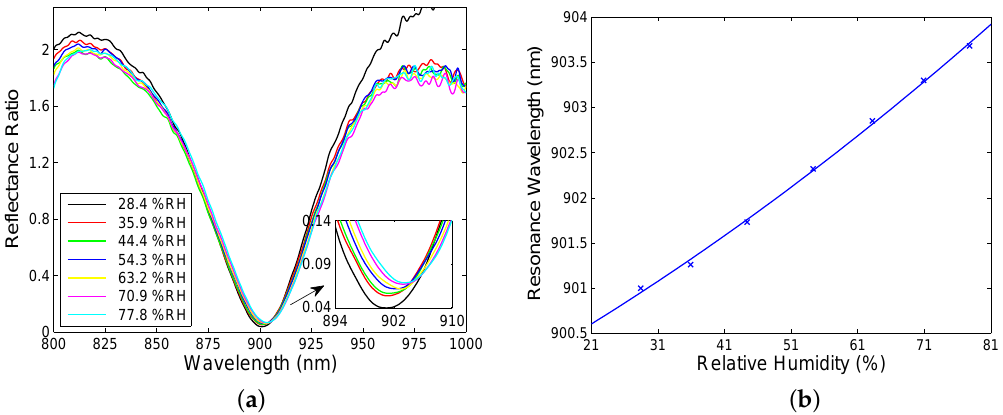
Figure 10. Spectral reflectance ratio R PA45 ( λ ) / R s ( λ ) for different values of the RH of moist air measured within the long-wavelength band gap (BSW2) ( a ). Resonance wavelength as a function of the RH of moist air with a polynomial fit ( b